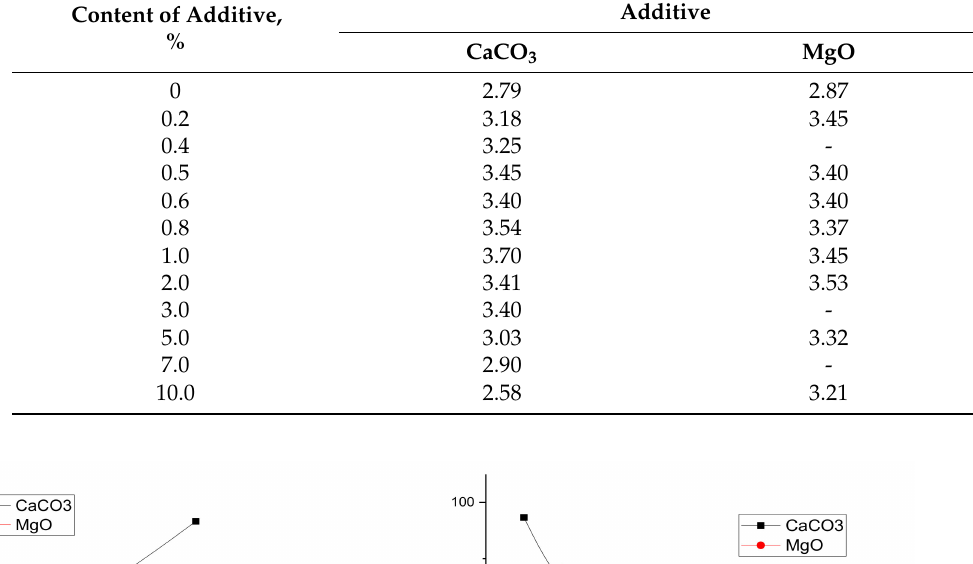
Table 3. Effect of different additive amounts on V 2 O 5a.s. content in roasted sludge, %.